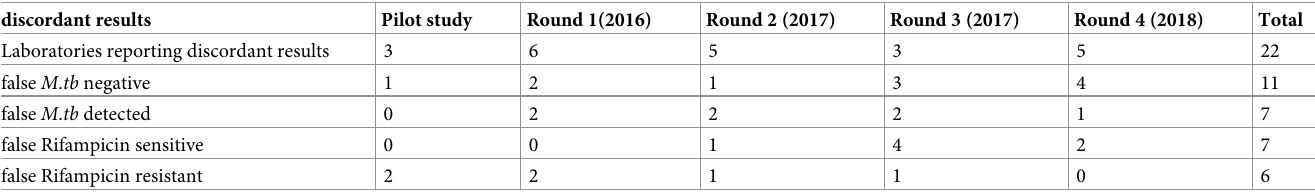
Table 5. Discordant results reported from the different